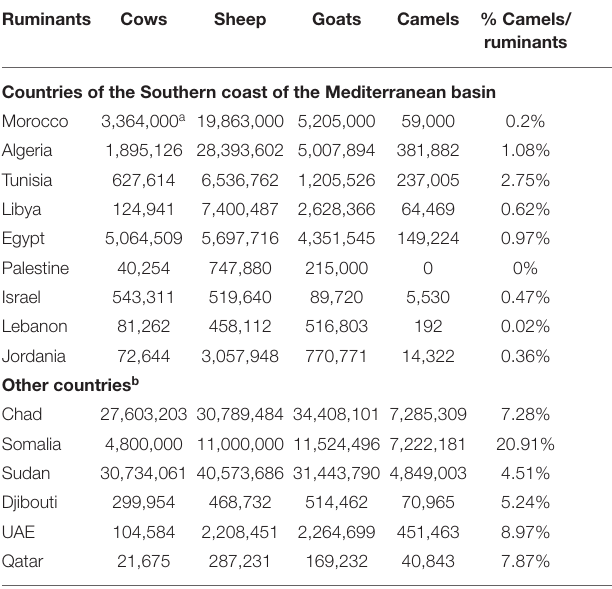
TABLE 2 | National productions of farm ruminants and percentage of dromedary camels with respect to the total number of other domestic ruminants (cows, sheep, and goats).